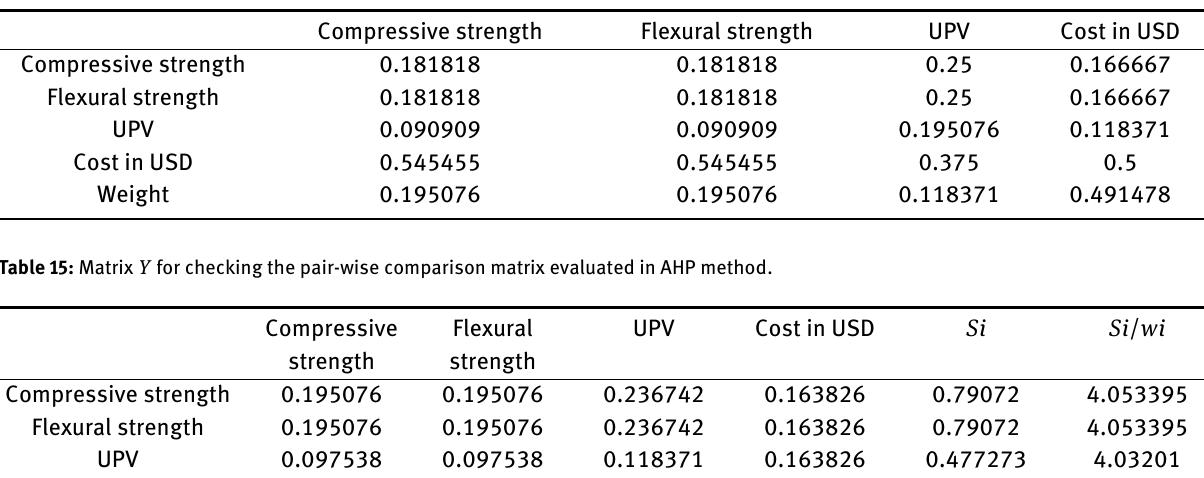
Table 14: Matrix X calculated and weights of criteria of reinforced green mortars (AHP method).